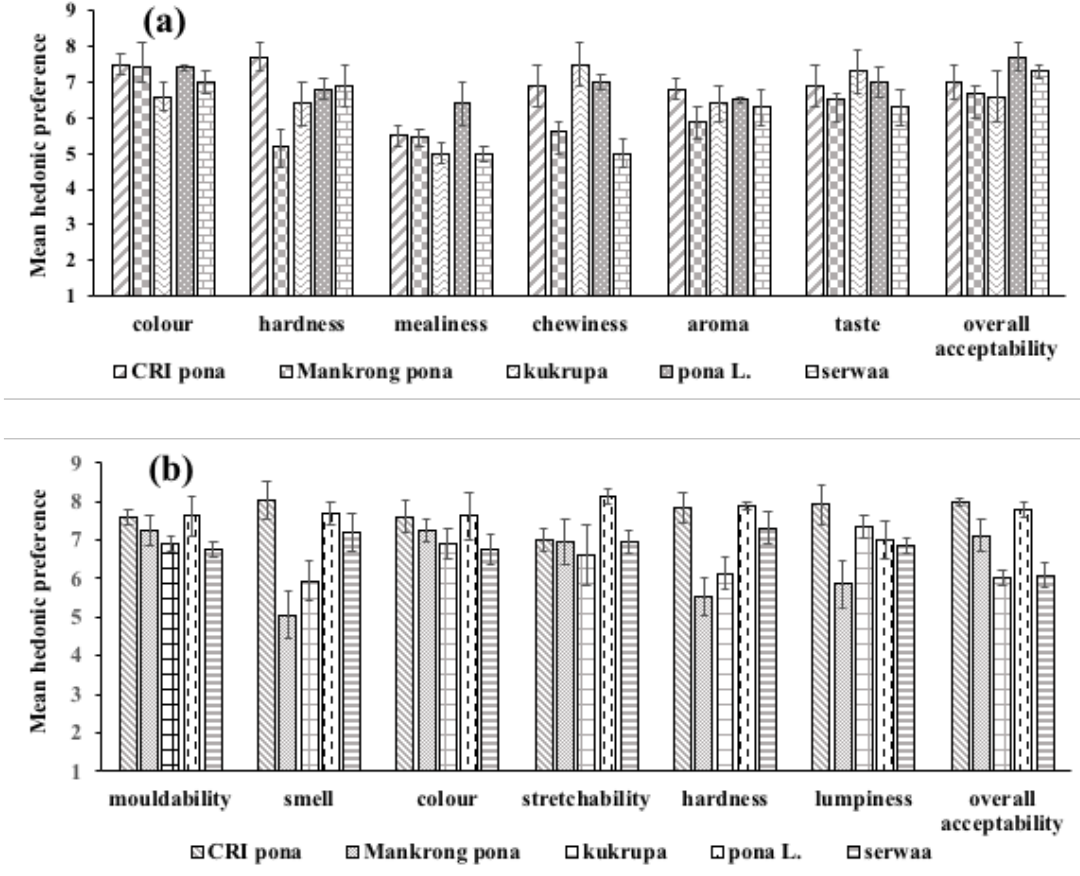
Figure 6. Preference level of quality descriptors of ( a ) boiled and ( b ) pounded Discorea retundata